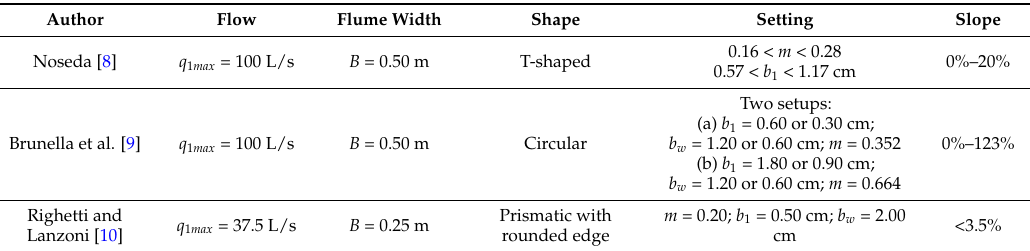
Table 1. Main features of previous bottom intake system